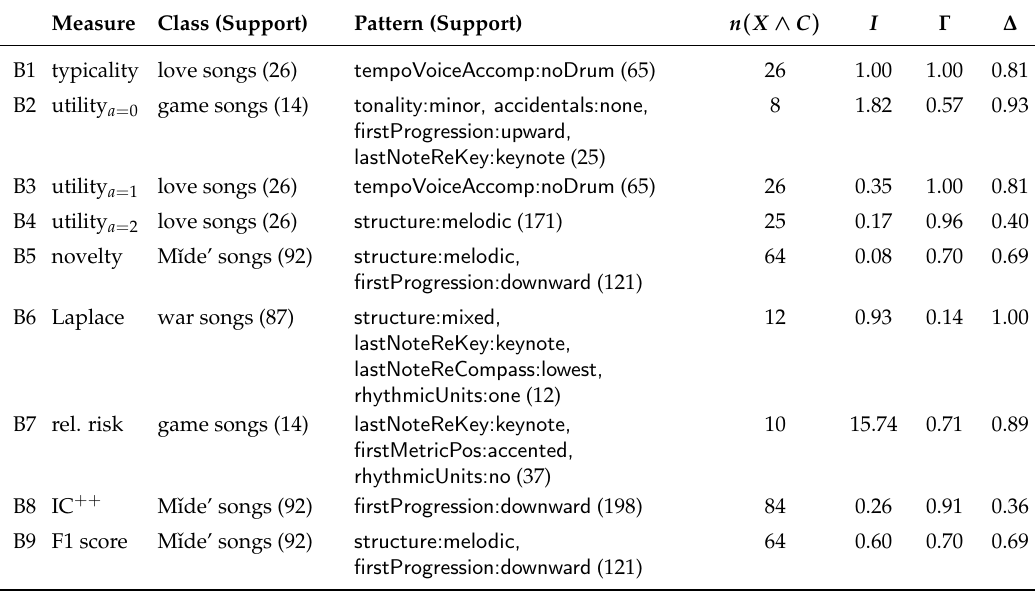
Table 5. Top-ranked patterns (by interestingness measure) in Case Study 2, with class support count n ( C ) , pattern support count n ( X ) , association support count n ( X ∧ C ) , interestingness I (according to the respective interestingness measure), completeness Γ , and discriminant power ∆